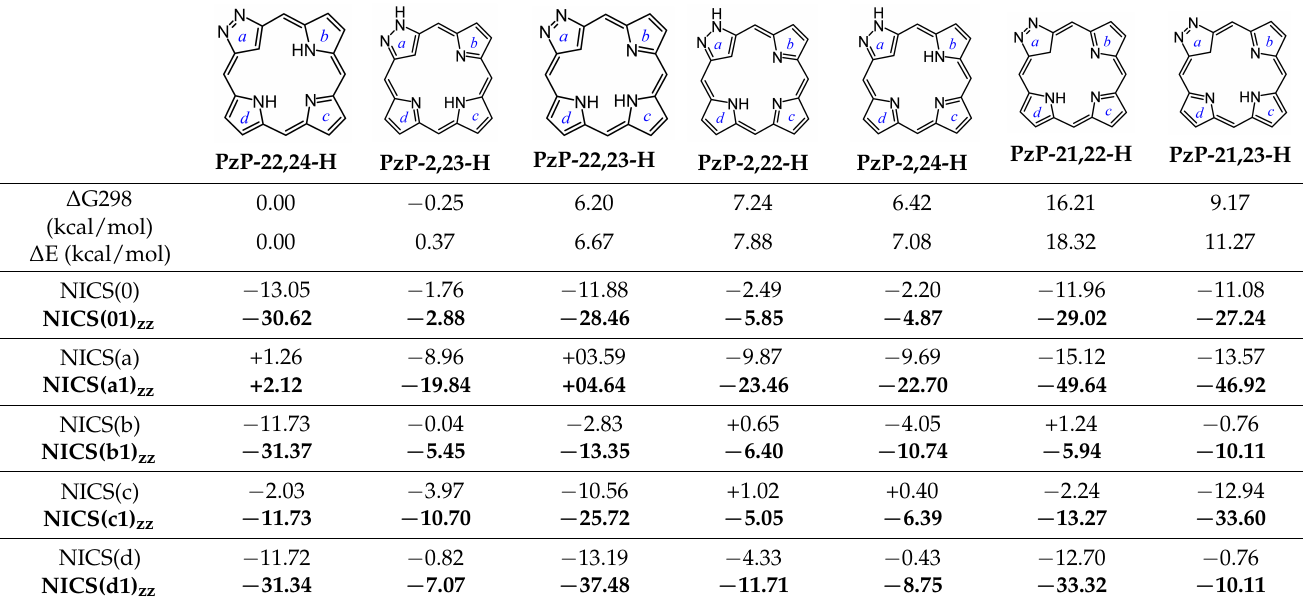
Table 1. Calculated Relative Energies (kcal/mol) and NICS Values (ppm) for Continuously Conju- gated Free Base Unsubstituted Pyrazoloporphyrin